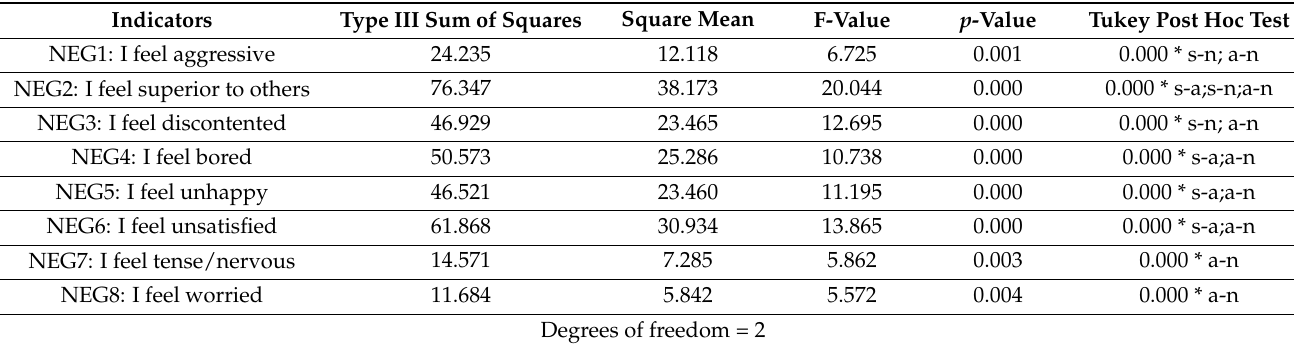
Table 6. Univariate tests and comparisons for negative